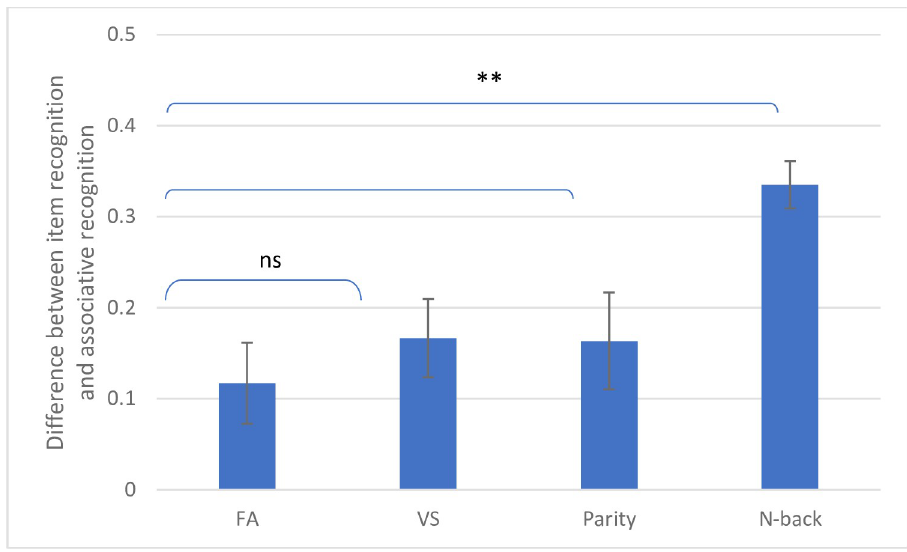
Fig 4. Associative deficit index (ADI) in the different attention conditions across the two experiments. FA = full attention, VS = visuopatial, �� p � 0.01.